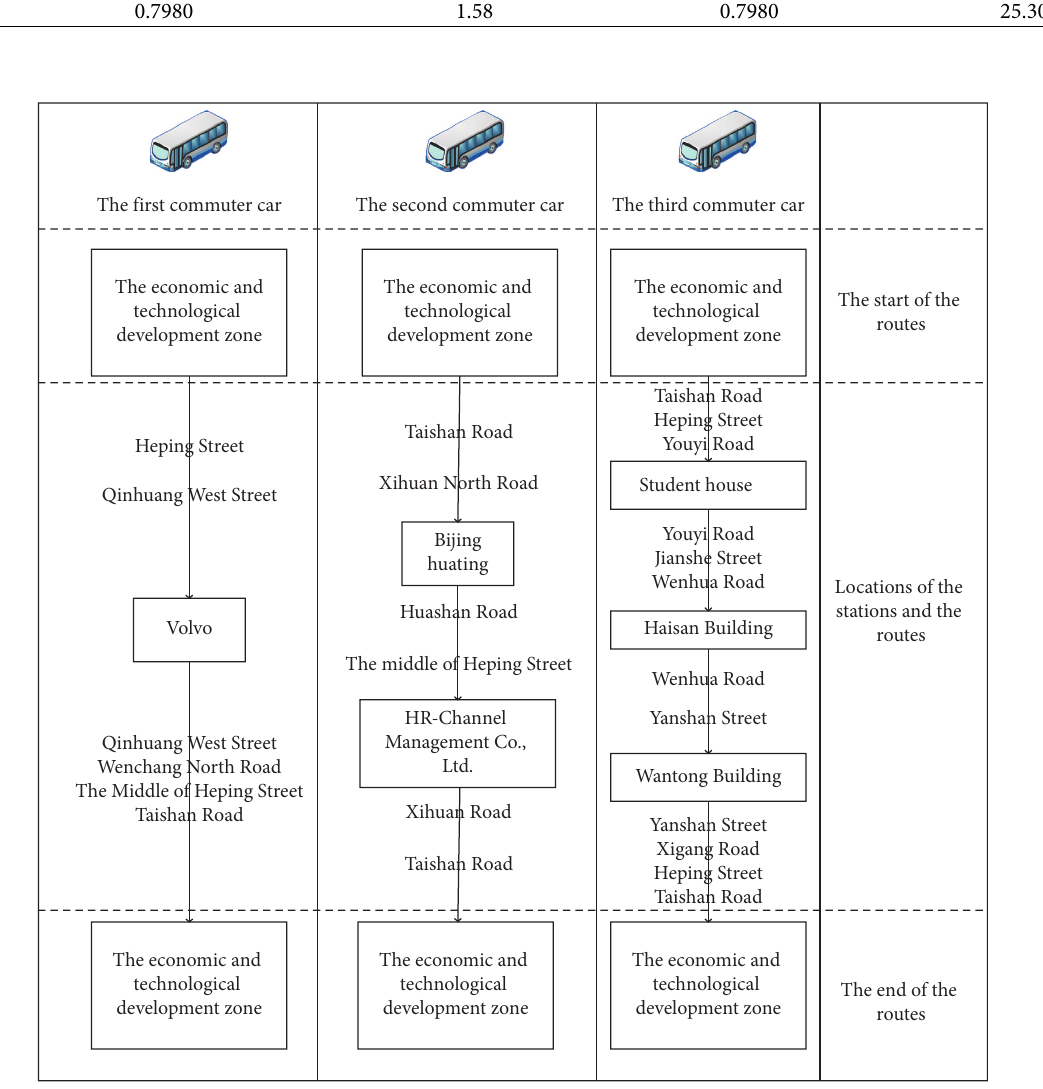
Figure 7: Design of initial routes for QETDZ and